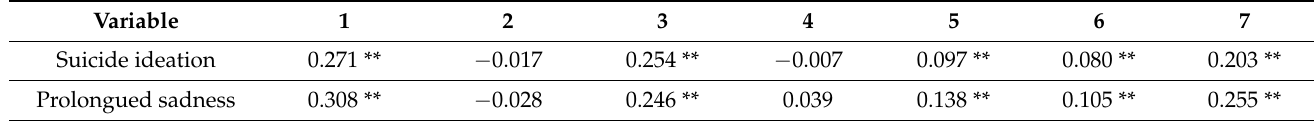
Table 3. Correlations between suicide ideation/prolonged sadness, and socio-emotional loneliness scale